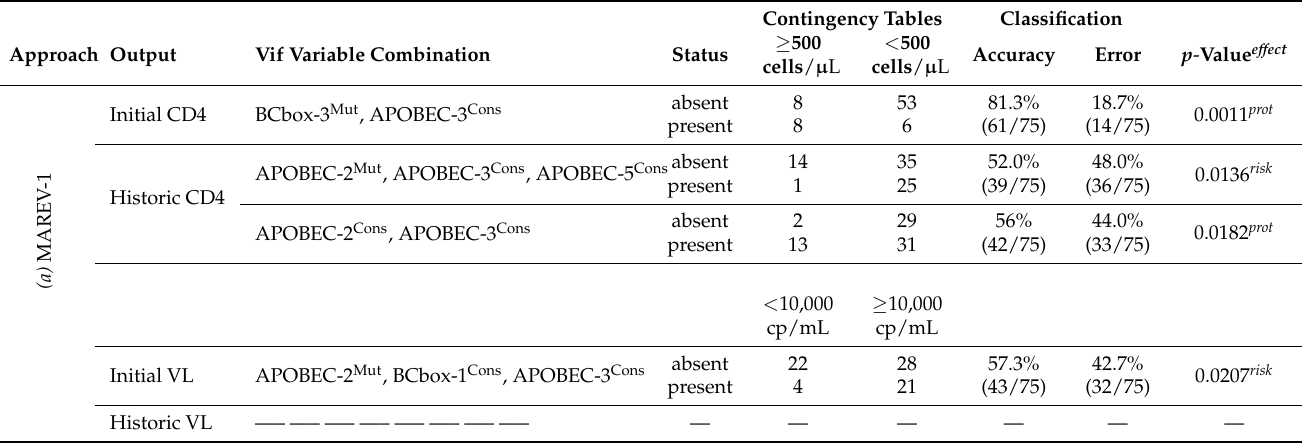
Table 3. The most relevant Vif protein variable combinations associated with the clinical endpoints. (a) Significant associations after testing the 20 hypothesis suggested by the MAREV-1 approach; (b) Significant associations after testing the 22 hypothesis suggested by the MAREV-2 approach. Vif protein regions can either be conserved (Cons) or mutated (Mut) and associated with protection ( prot ) or risk to either <500 cells/ µ L CD4 T cells or ≥ 10,000 cp/mL of viral